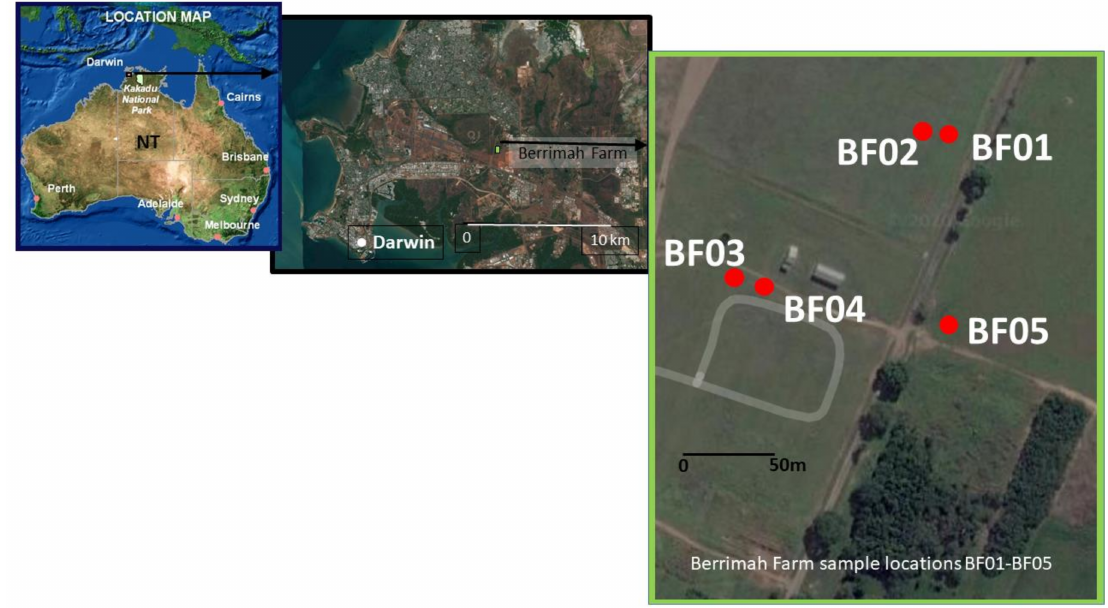
Figure 1. Study site. Berrimah is a suburb of Darwin in the Northern Territory of Australia. There are five sites labelled Berrimah Farm (BF) or BF01-05. The five sites were within proximity of each